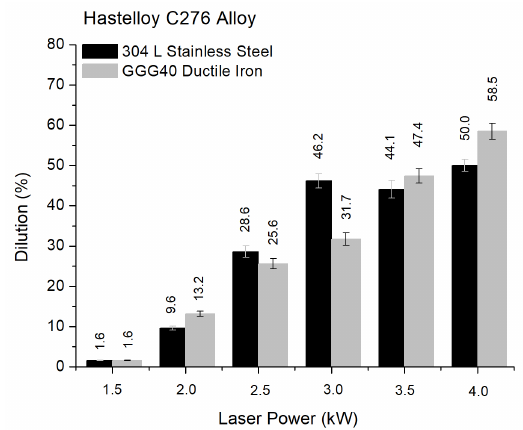
Figure 5. Typical dilution by areas method 3 .